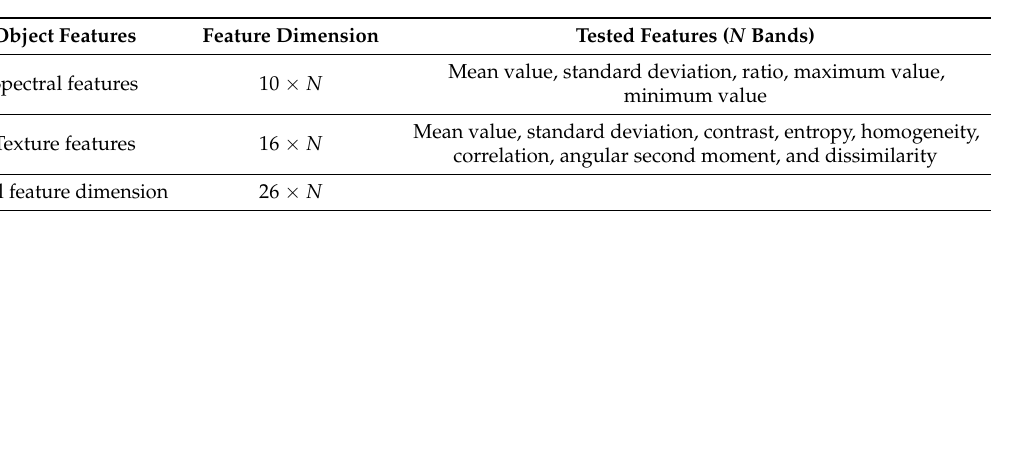
Table 1. Overview of extracted